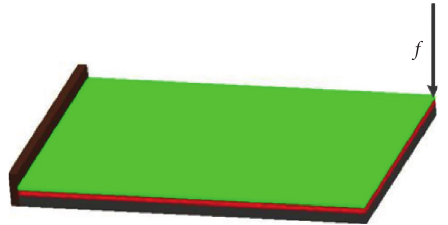
Figure 5: The cantilever rectangular plate. Table 7: Topological designs of viscoelastic damping material microstructures with the same volume